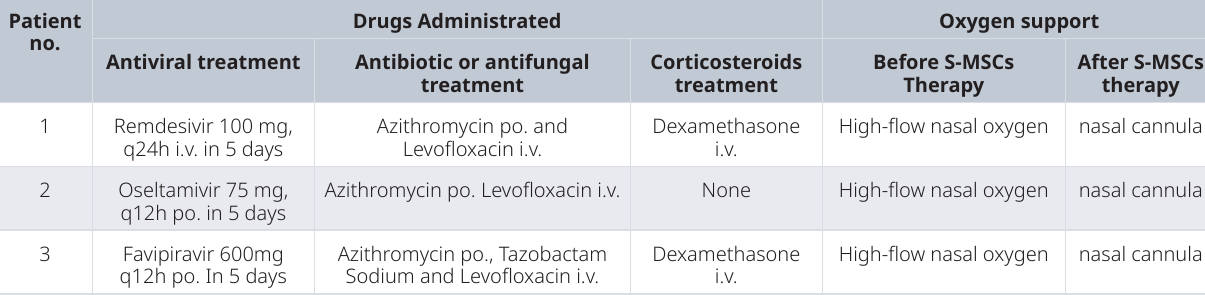
Table 2. Standard treatment received by the three patients receiving S-MSCs. Patient no.